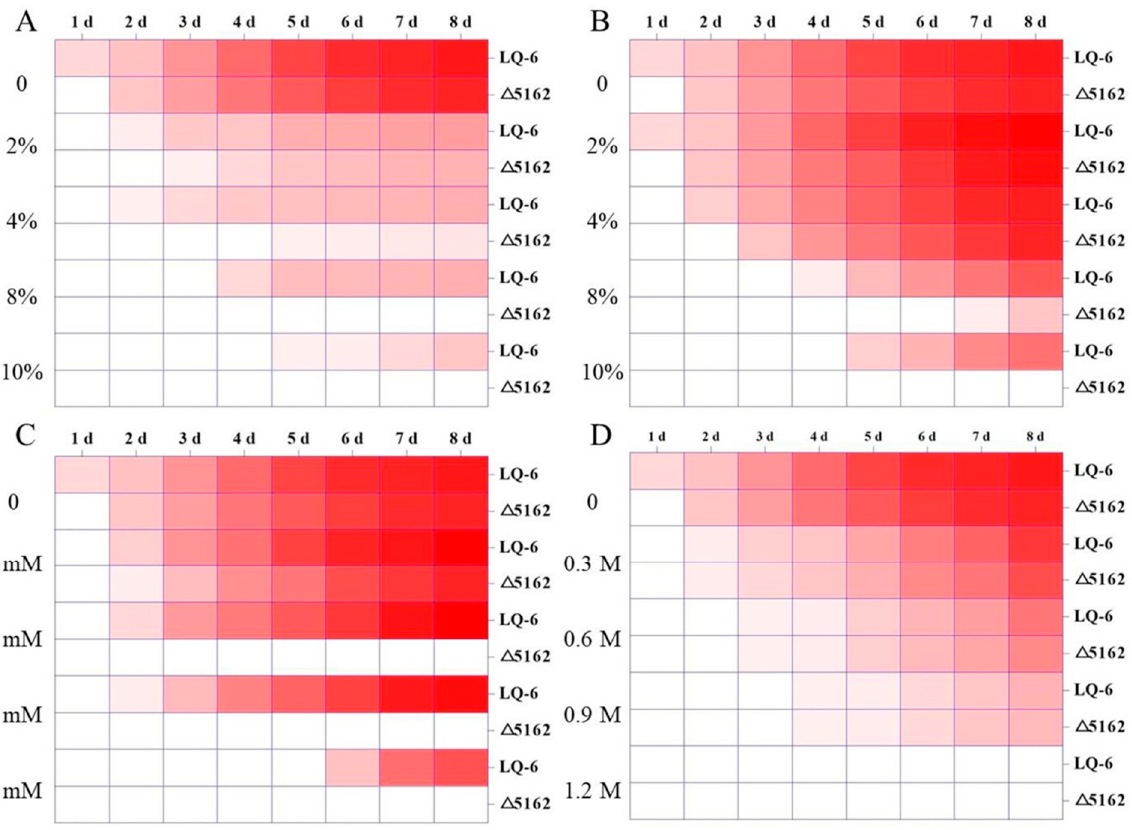
Figure 2. The sensitivities of parent strain M. purpureus LQ-6 and chs 6-deleted strain M. purpureus ∆ 5162 cultured on PDA medium at 30 ◦ C in the dark to lactic acid ( A ), ethanol ( B ), H 2 O 2 ( C ), and NaCl ( D ). Red color represents normal cell growth, white color represents the cell growth is completely inhibited.